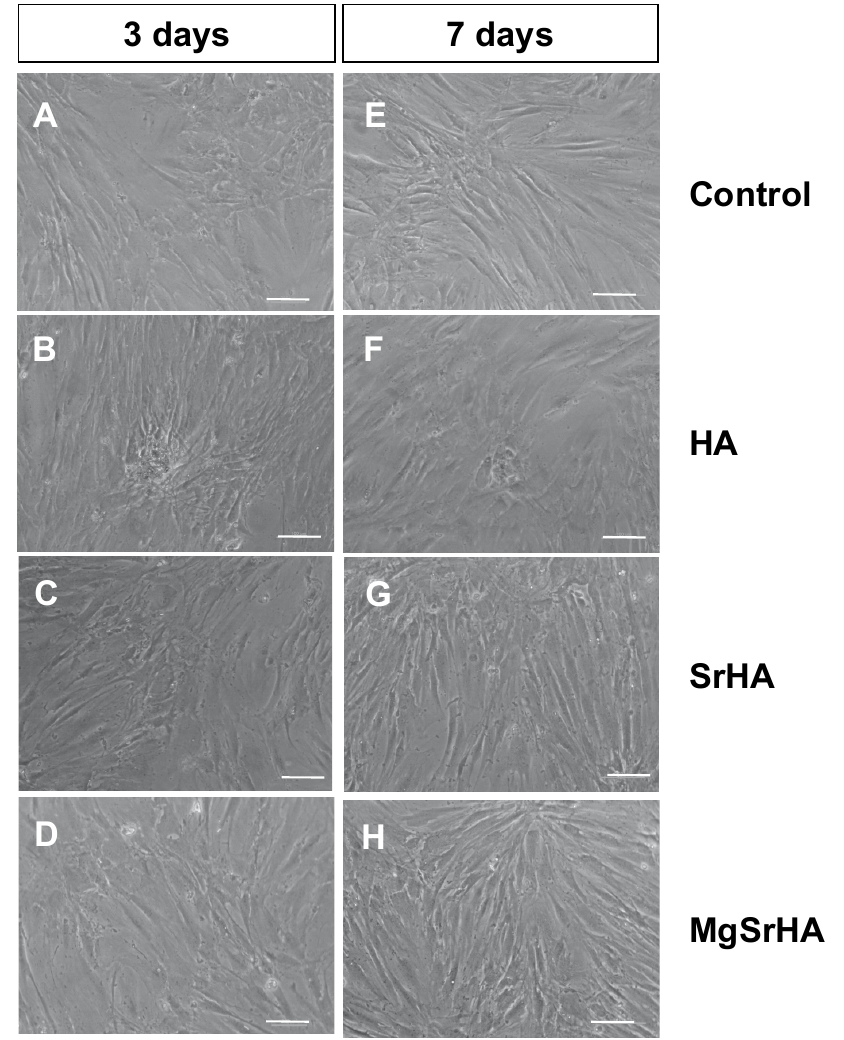
Figure 2. Indirect biocompatibility assay: microphotographs of primary human osteoblasts cultured in the presence of ( A , E ) complete pristine DMEM or previously conditioned with ( B , F ) hydroxyapatite (HA), ( C , G ) Sr-substituted HA (SrHA), or ( D , H ) magnesium, strontium-substituted HA (MgSrHA). Cells were observed at phase contrast after ( A – D ) three days or ( E – H ) seven days of culture. Magnification: 10 X. Bar = 20 μ m.